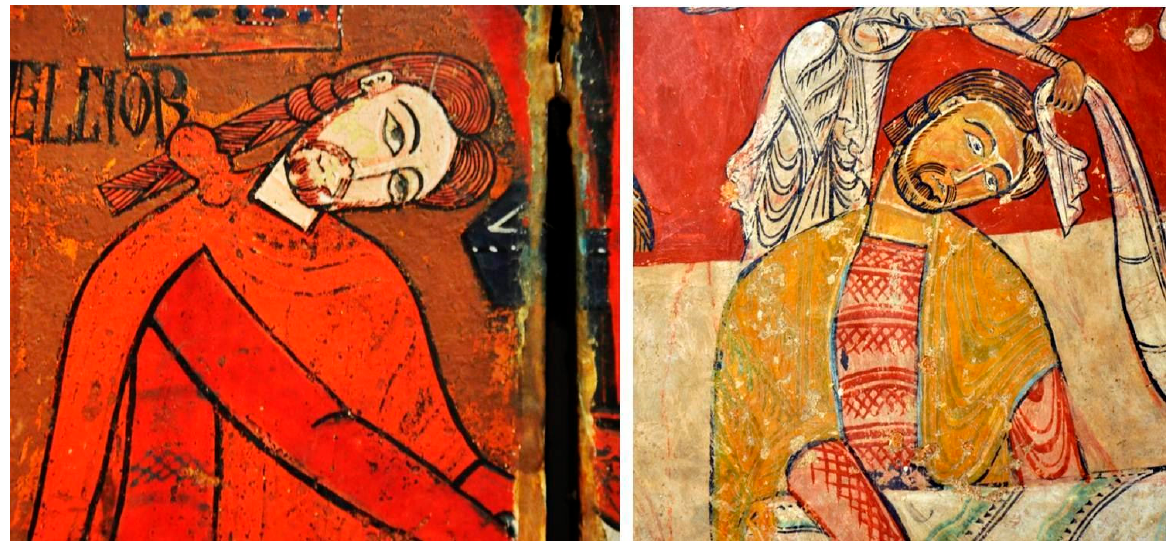
Figure 14. Composition comparing Magi Melchior from the Espinelves altar frontal ( left ) with the figure of a monk from the Terrassa wall paintings ( right ).